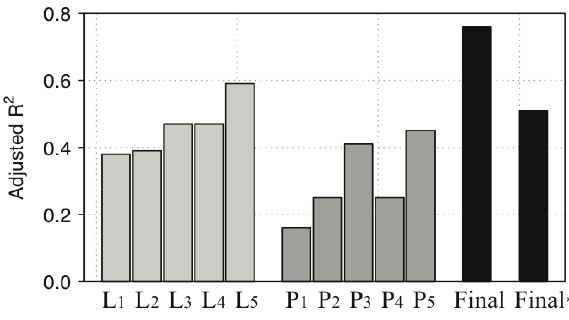
Figure 10. Bar plot of 𝑅 2 (refer to Table